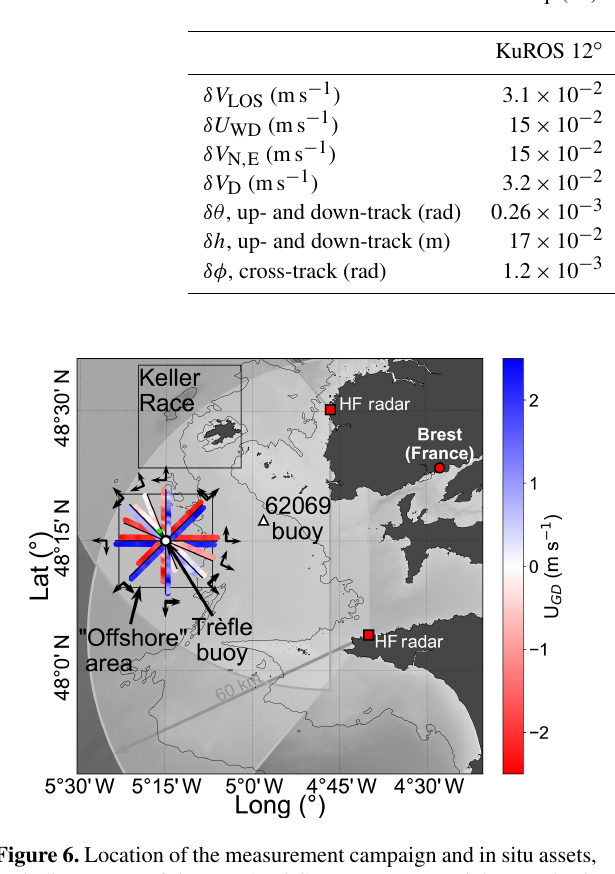
ing information with stated tolerances of a few centimeters, 0.005, 0.005 and 0.01 ◦ ,